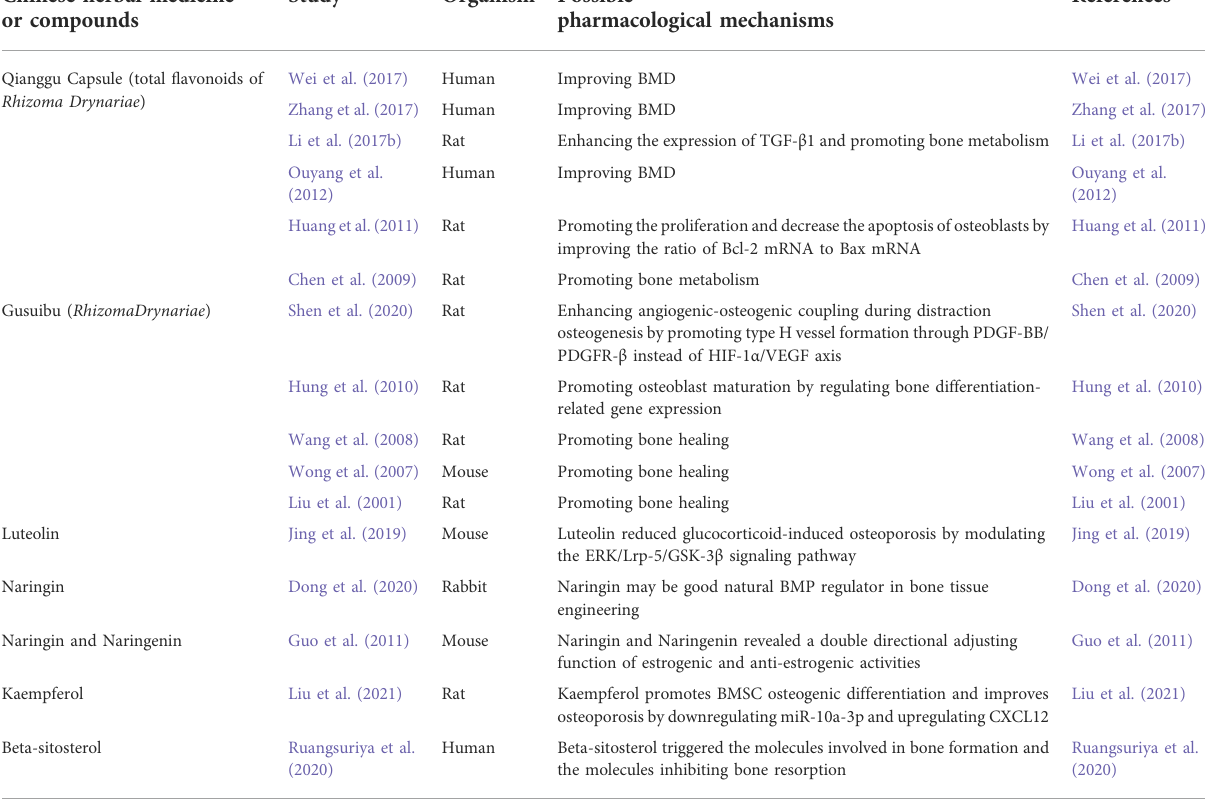
TABLE 3 Studies related to the regulation of bone metabolism by Qianggu Capsule and its active compounds. Chinese herbal medicine or